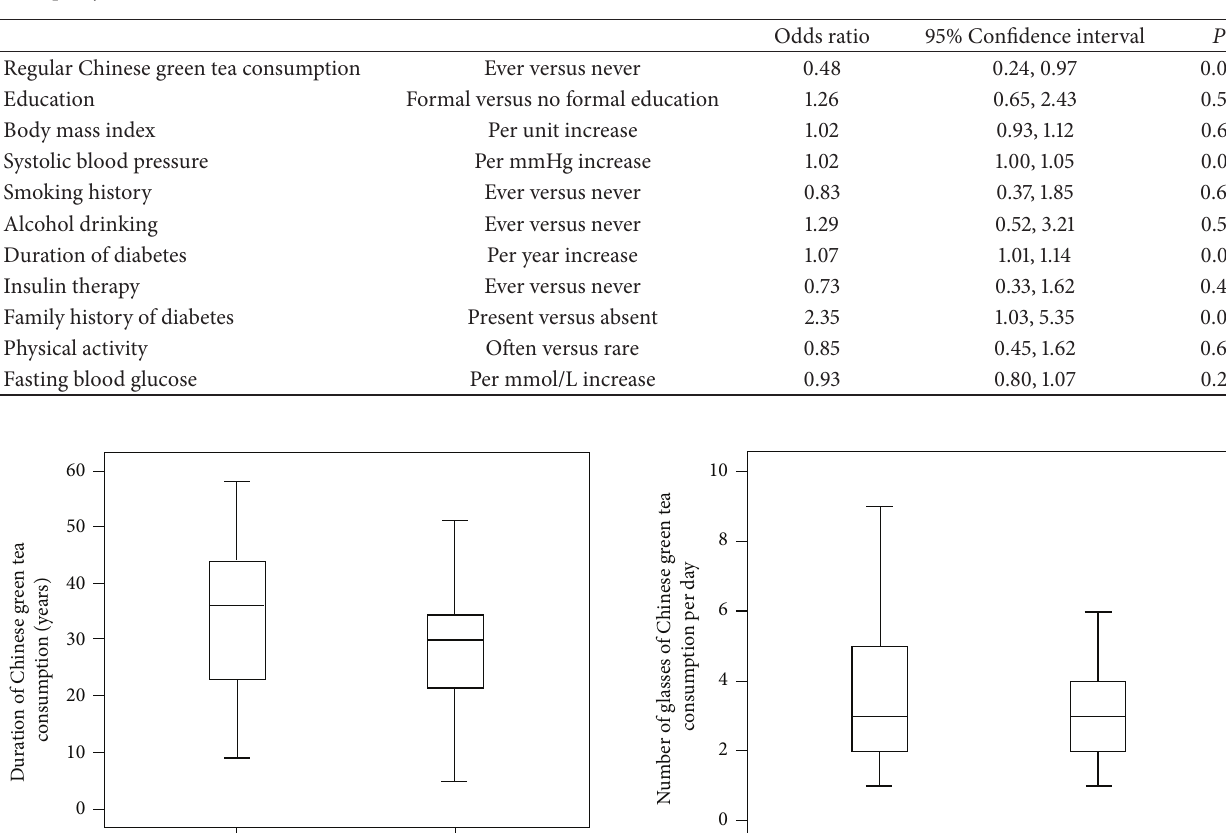
Table 4: Multivariate analysis on the associations of regular Chinese green tea consumption and other potential risk factors with diabetic retinopathy.